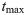
Average fraction of infected nodes as a function of time in units of 〈tr〉 for various networks with equal average degree, 〈k〉 = 40, but different clustering properties, depending on μ.The ER network shows the result on an Erdős-Rényi random network [25] with 〈k〉 = 40 and zero clustering. The lines going through the data are fits to Eq (36), leaving a, I0 and tmax as free parameters.